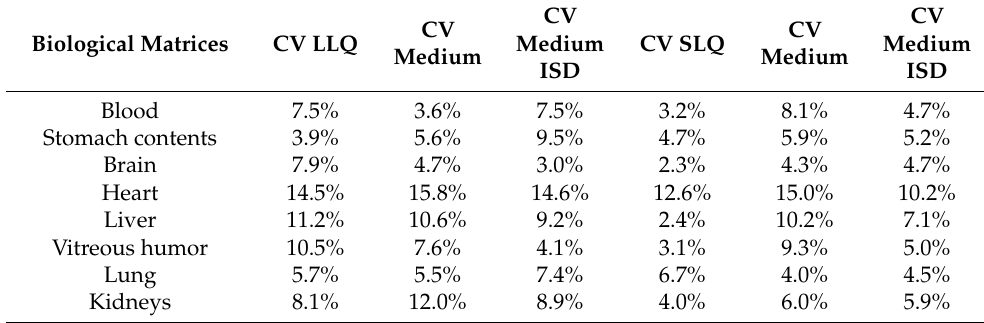
Table 16. Coefficient of variation (CV) of the lower limit of quantification (LLQ) and the superior limit of quantification (SLQ), as well as the average CV (average of the CV of the other points of the calibration curve), and of the internal standard (ISD) in the different matrices, expressed in percentage of